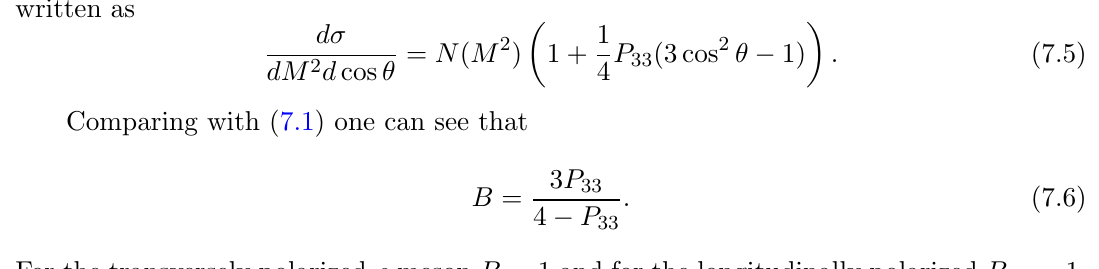
The di(cid:11)erential cross section for the decay of (cid:26) meson to the lepton pair may be written